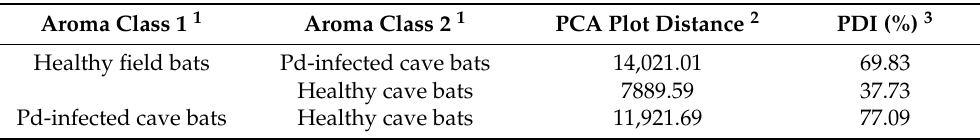
Table 8. Chemical relatedness between electronic-nose VOC-profiles of P. subflavus bat whole-body headspace volatiles analyzed by 3-d PCA with pattern discrimination index.